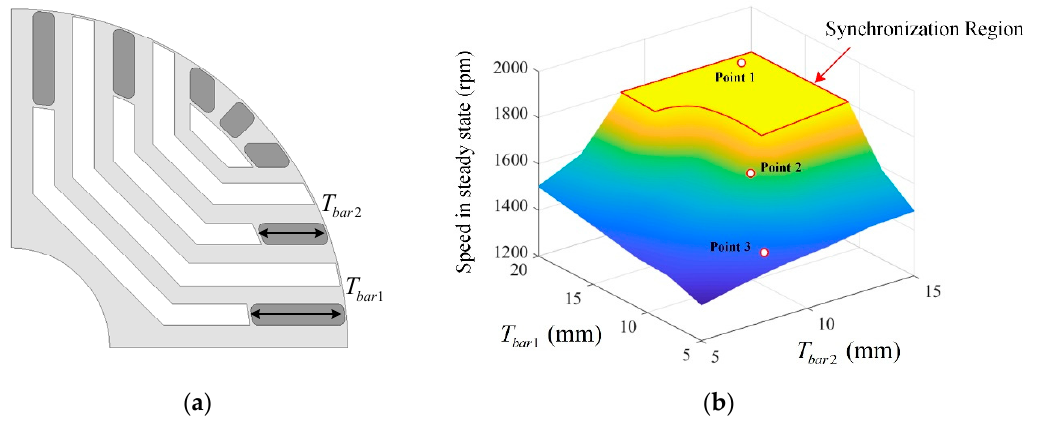
Figure 9. Design parameter of rotor slot and FEA result ( a ) design parameter, ( b ) FEA result.